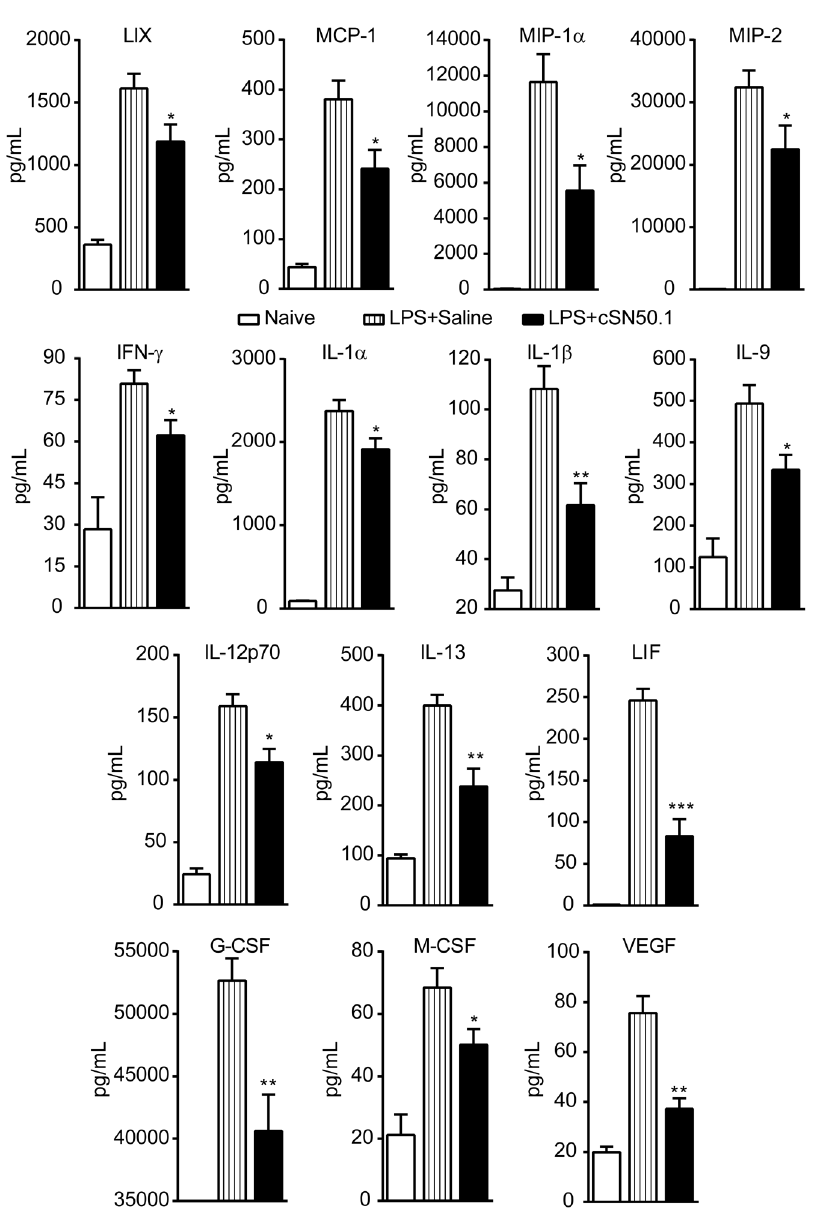
Figure 4. LPS-induced expression of chemokines, cytokines, and growth factors in the lung is suppressed by NTM. Fourteen cytokines, chemokines and growth factors elevated in BAL after direct airway exposure to LPS are significantly suppressed by NTM (cSN50.1 peptide) treatment. Data are presented as mean 6 standard error, n =4 naı¨ve and 8–9 NTM- or saline-treated animals/group from 3 independent experiments. * p , 0.05, ** p , 0.005, and *** p , 0.0005 by Mann-Whitney U test comparing LPS-challenged